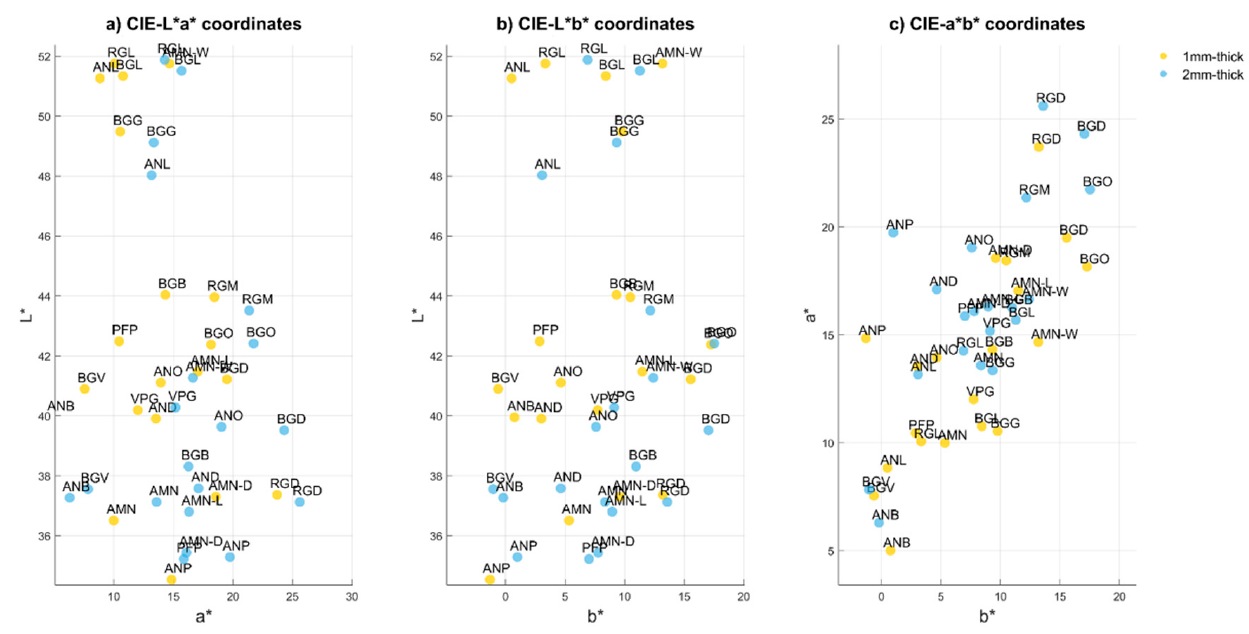
Figure 2. CIE L*a*b* color coordinates 2D representation of the samples measured against air: ( a ) CIE L*a* coordinates; ( b ) CIE L*b* coordinates; ( c ) CIE a*b* coordinates.